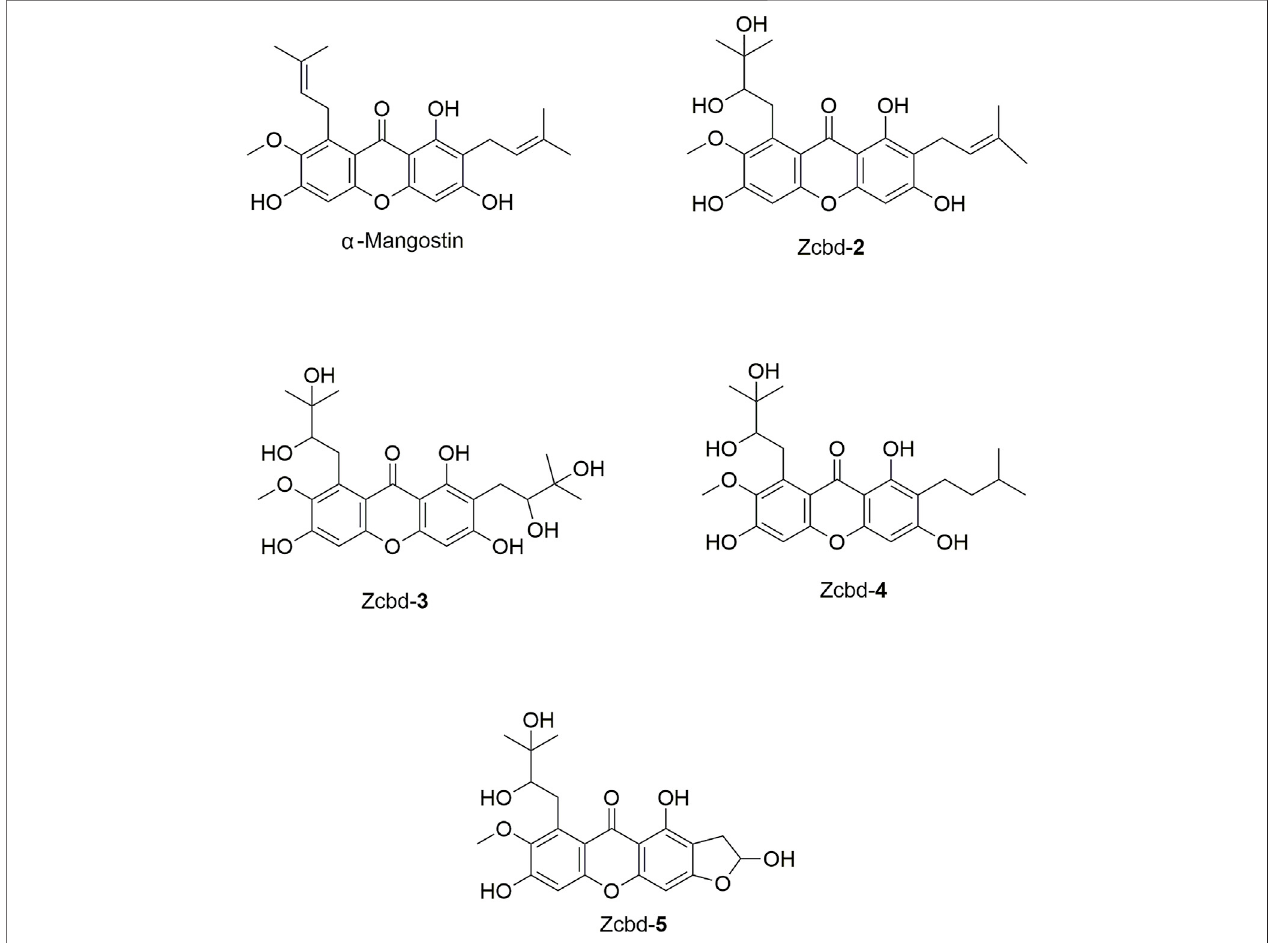
FIGURE1| The chemical structure formulas of α -Mangostin( α -M), Zcbd- 2 ,Zcbd- 3 ,Zcbd- 4 and Zcbd- 5 .Molecularformula: C 24 H 26 O 6 ( α -M), C 24 H 28 O 8 (Zcbd- 2 ),